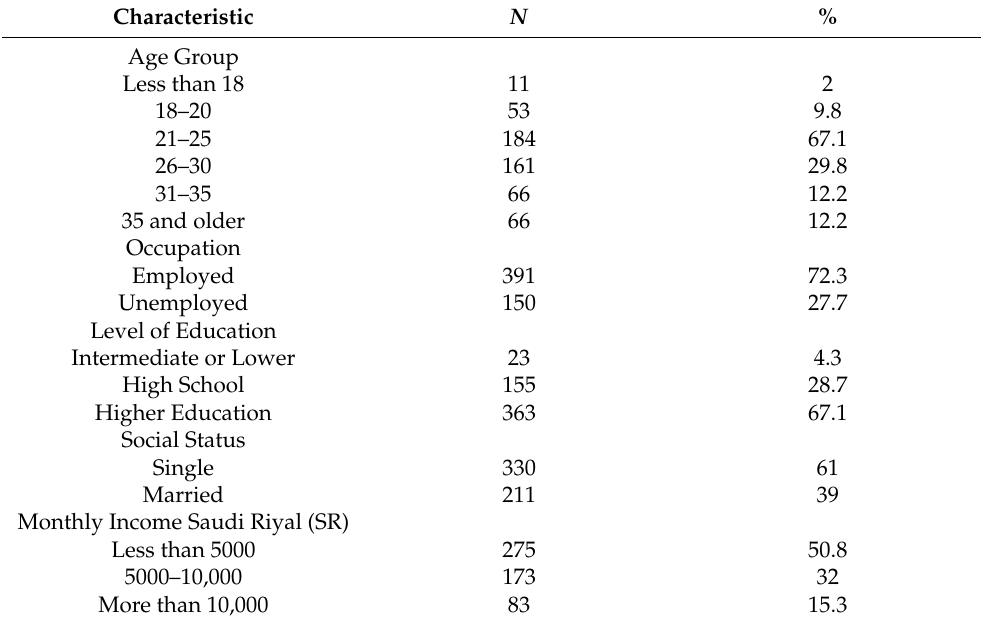
Table 1. Sociodemographic characteristics ( n = 541).